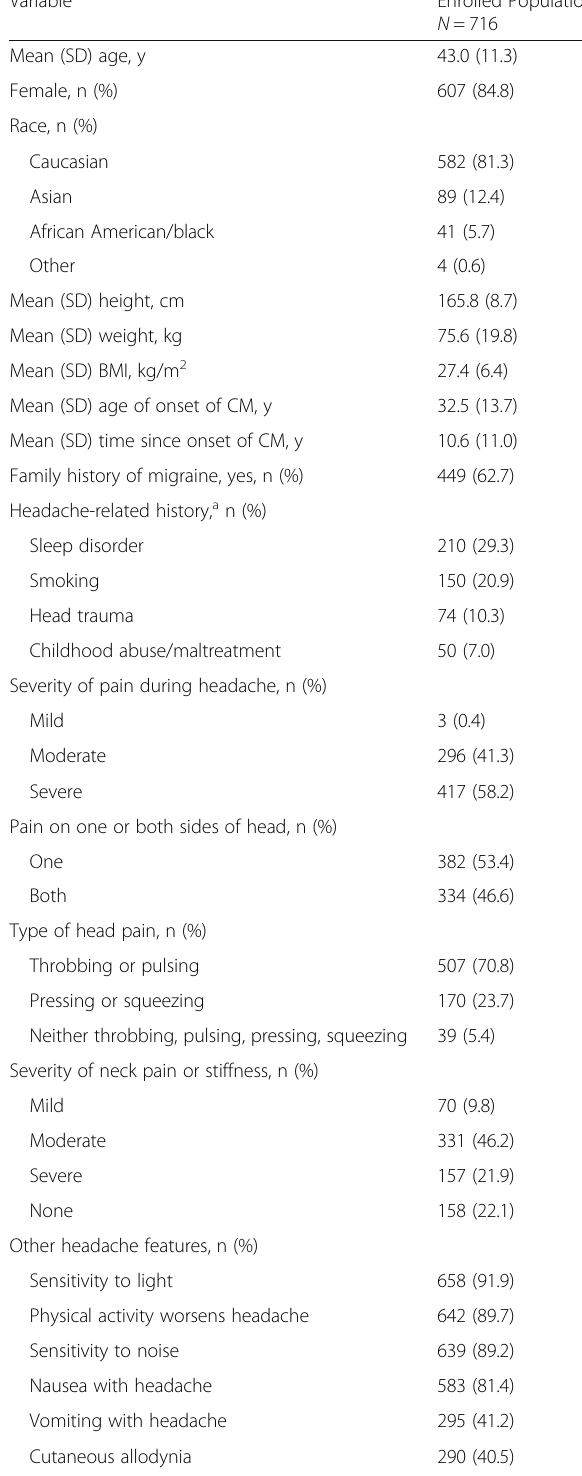
Table 1 Baseline Demographics and Clinical Features of CM (Continued)